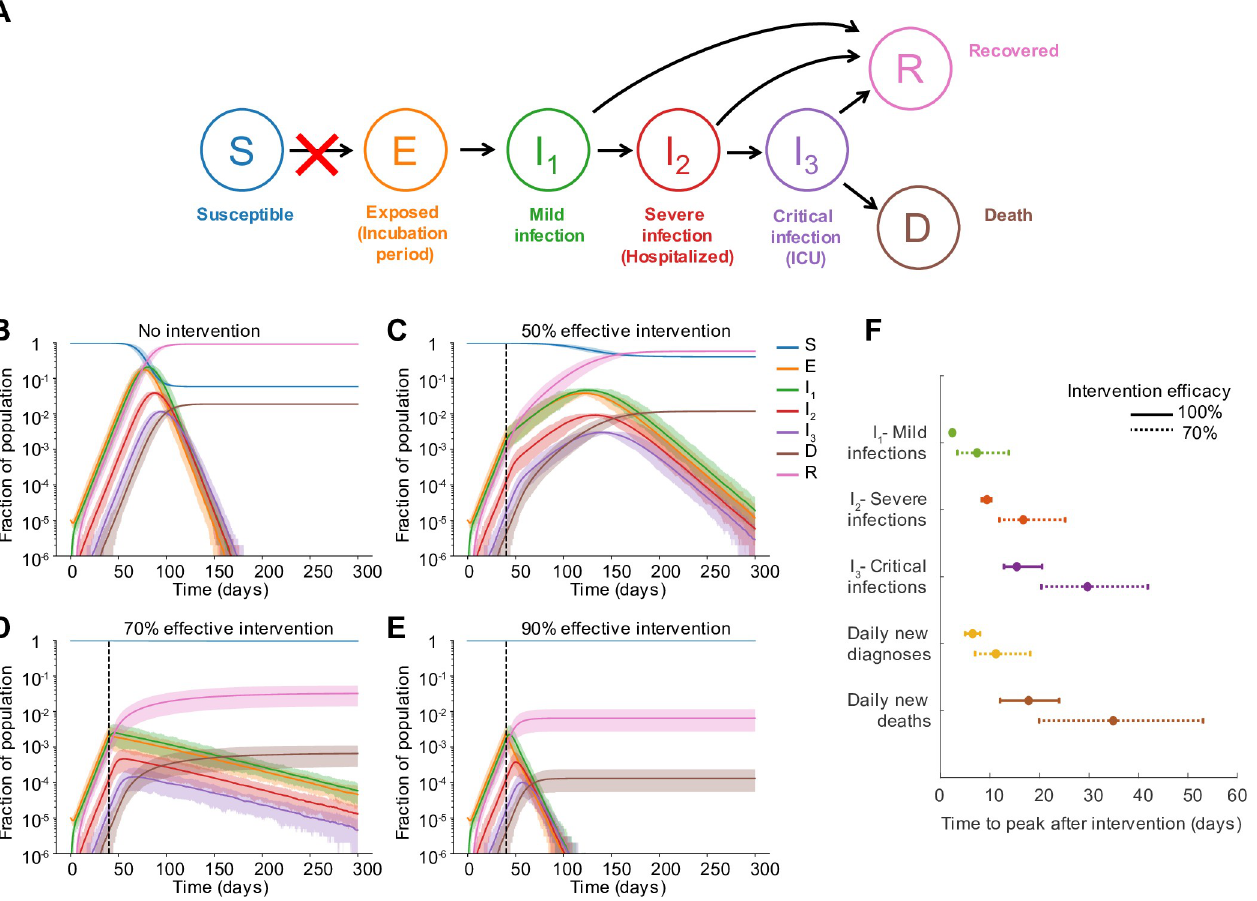
Fig 2. Dynamics pre and post social distancing intervention in well-mixed populations. A) Model of COVID-19 clinical progression and transmission. The model is described in the text and detailed in the Methods. Social distancing interventions (red X) reduce the rate of transmission and the generation of new infections. B-E) Simulated time course of the population level prevalence of each clinical stage of infection under different intervention efficacies. The intervention was implemented on day 40. Solid line is mean and shaded areas are 5th and 95th percentile. Black dotted line shows the time the intervention began. F) Time to peak of different infection stages, measured as days post-intervention. The first three quantities are peak prevalence levels (I 1 , I 2 , I 3 ), while the latter two are peak daily incidence values. We assume that cases are diagnosed only at the time of hospitalization. Daily incidence values were first smoothed using moving averages over a 7 day window centered on the date of interest. Bars represent 5th and 95th percentile.